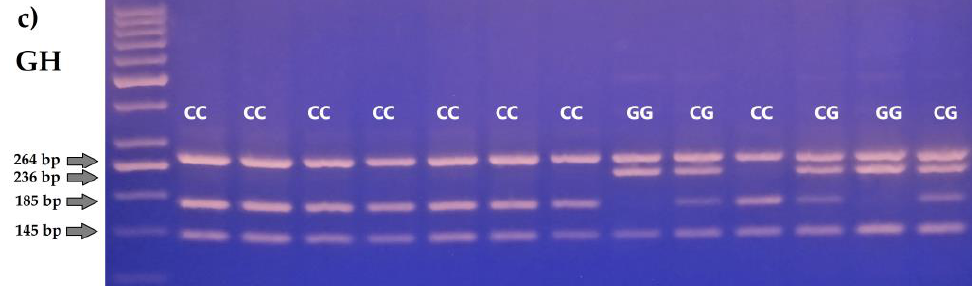
Figure 1. Determination of allelic variants of FASN ( a ), SCD ( b ), and GH ( c ) gene on gel.